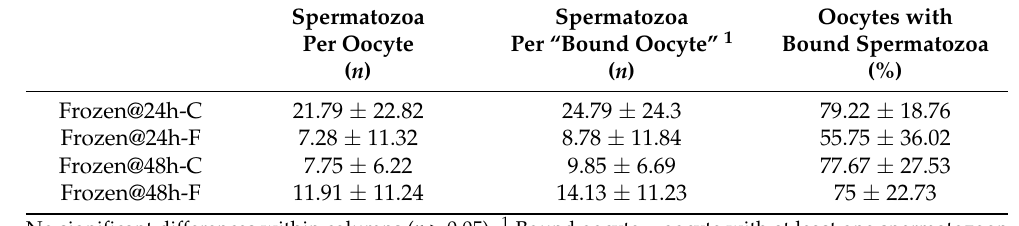
Table 6. Post-thaw ability of ejaculated canine spermatozoa to bind homologous zonae pellucidae after dilution with chilling (C) or freezing extender 1 (F), chilling and storage for 24 or 48 h in a transport box, and Uppsala freezing.